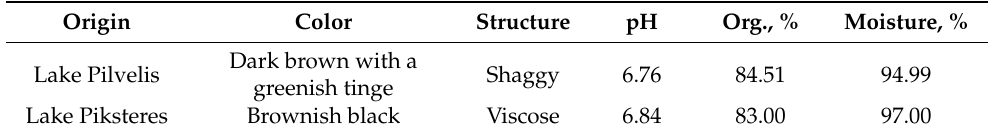
Table 1. Characteristics of sapropel samples.